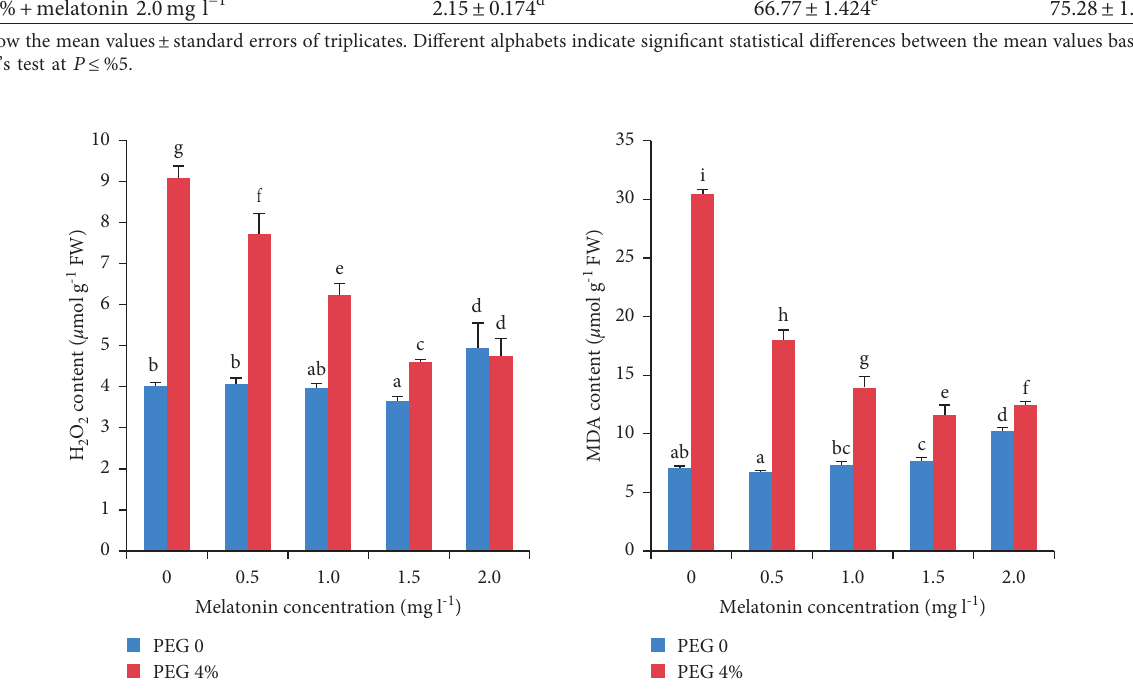
Figure 2: H 2 O 2 and MDA content in H. pusillus calli cultures treated with melatonin concentrations and PEG levels after 28 days. Vertical bars indicate the standard errors of triplicates. Different alphabets indicate significant statistical differences between the mean values based on Duncan’s test at P ≤